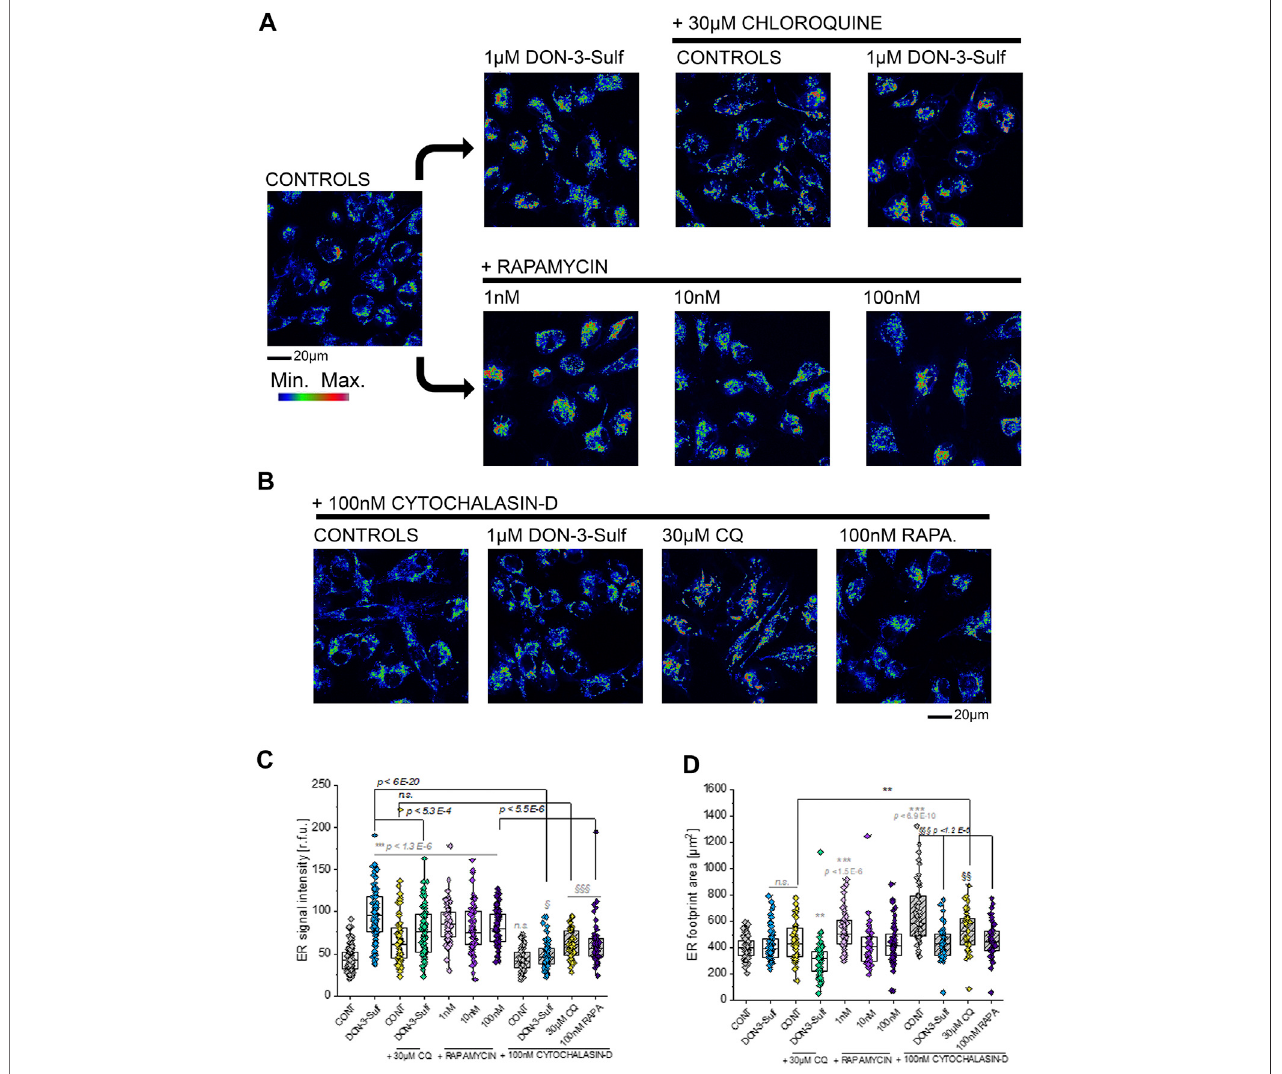
FIGURE 8 | Morphometric profiling of the endoplasmic reticulum (ER). (A) Representative appearance of cells in control conditions and after 24 h incubation with 1 µM DON-3-Sulf and/or 30 µM chloroquine (CQ) or 1 – 100 nM rapamycin (RAPA.). (B) Representative appearance of cells after 24 h incubation with 100 nM cytochalasinDand1 µMDON-3-Sulf,30 µMchloroquine,or100 nMrapamycin. (C) Quanti fi cationofthesignalintensityoftheERexpressedasrelative fl uorescentunits (r.f.u.). (D) Quanti fi cation of the average ER footprint area/cell. For every condition, data result from the quanti fi cation of n > 50 ROI/cells. Gray symbols: * indicates signi fi cant difference in comparison to controls at the Student ’ s t -test (*: p ≤ 0.05; **: p ≤ 0.01 ***: p ≤ 0.001). Black symbols: * indicates signi fi cant difference between incubationswithorwithoutcytochalasinDattheStudent ’ s t -test(*: p ≤ 0.05;**: p ≤ 0.01;***: p ≤ 0.001).§indicatessigni fi cantdifferenceincomparisontocytochalasinD controls at the Student ’ s t -test (§: p ≤ 0.05; §§: p ≤ 0.01 §§§: p ≤ 0.001; scale bar: 20 µm).